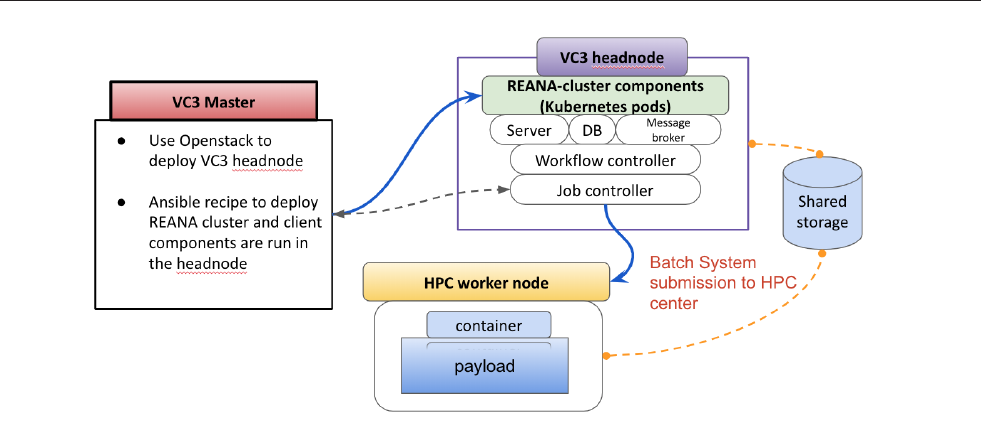
Figure 2. REANA cluster deployment via VC3